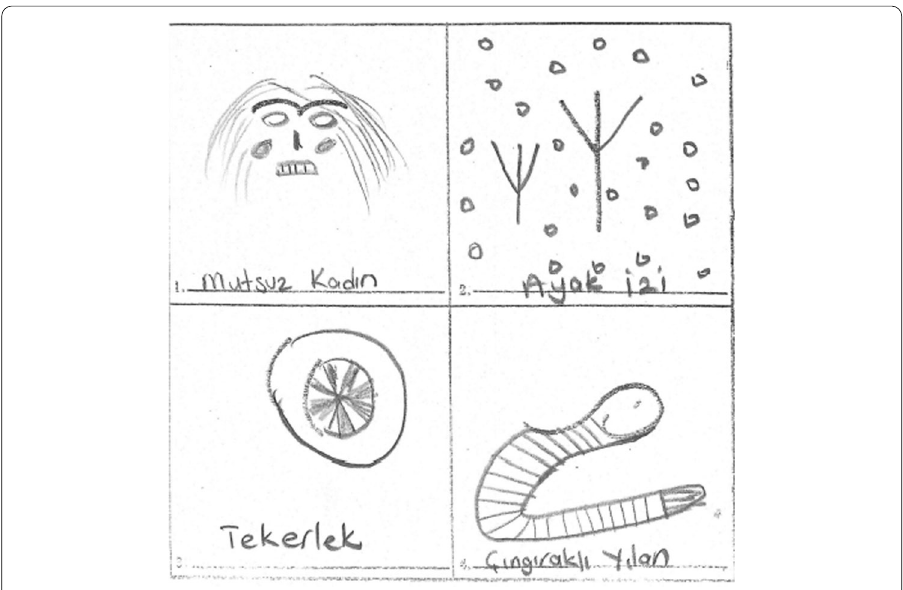
Fig. 5 Post-test responses of the figure completion